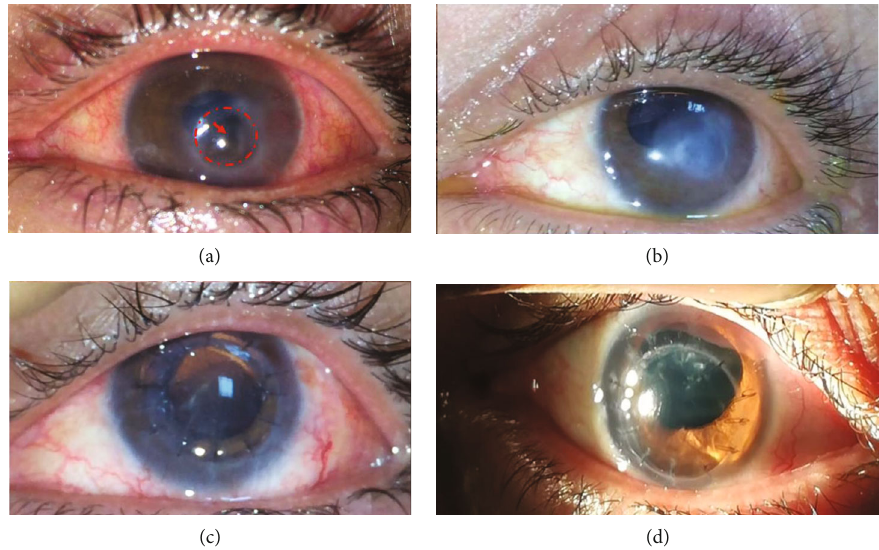
Figure 1: Slit-lamp photos of case #3 showing. (a) Descemetocele and perforation with iris prolapse and inferior AC loss 11 days after intrastromal amphotericin injection. (b) Corneal opacity and epithelialized corneal surface 5 weeks after multilayered fresh amniotic membrane transplantation. (c) Clear full-thickness corneal graft secured with interrupted 10/0 nylon sutures (1 st postoperative day). (d) Healthy corneal graft 9 months after